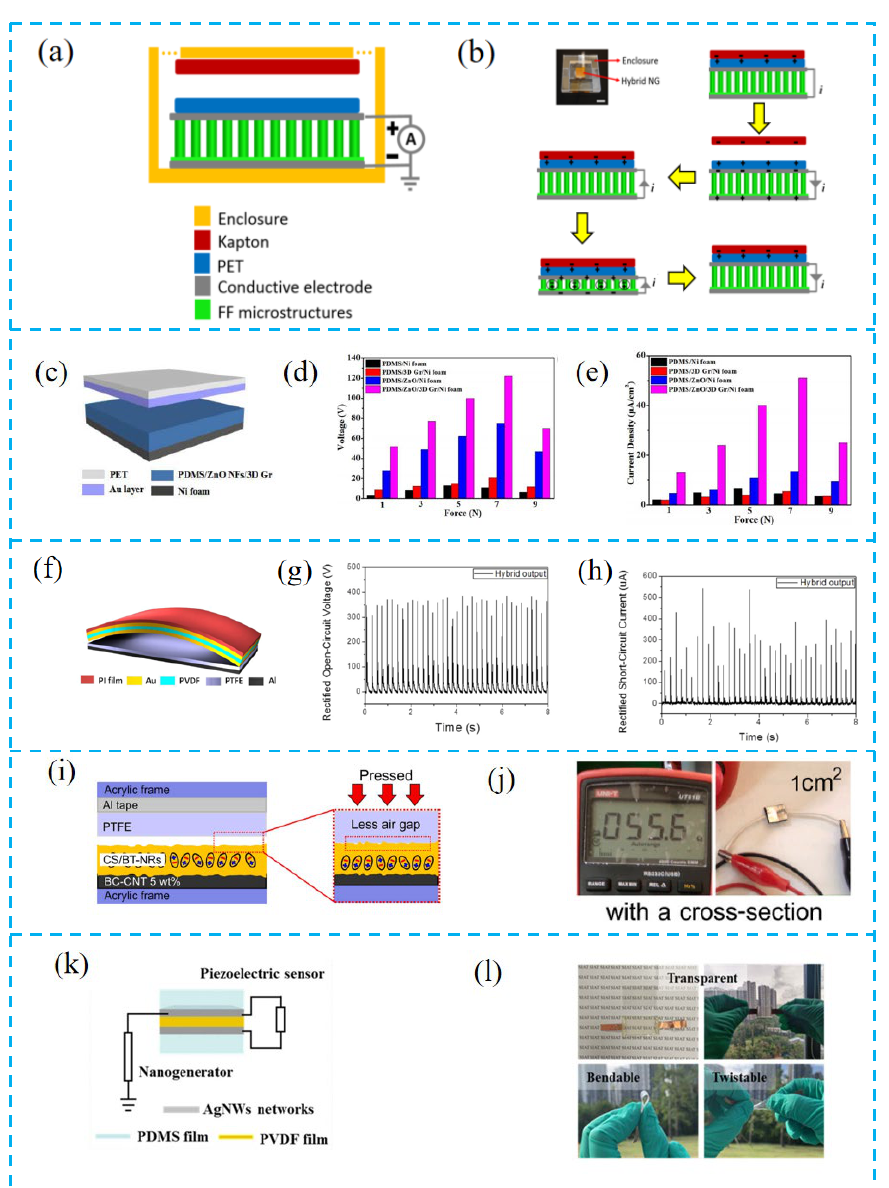
Figure 3. ( a ) Schematic of the structure of the PTCNG. ( b ) Photograph and energy conversion process of the real PTCNG. ( c ) Schematic structure diagram of a PDMS/ZnO nanoflakes/3D graphene- based PTCNG. ( d , e ) Comparison of the open-circuit voltage and short-circuit current density under different device structures. ( f ) Schematic structure diagram of an arc-shaped PVDF-PTFE-based PTCNG. ( g , h ) Open-circuit voltage and short-circuit of the arc-shaped PVDF-PTFE-based hybrid nanogenerator. ( i ) Schematic diagram of device structure based on the soft BC-CNT conformable electrode. ( j ) Conductivity of a soft BC-CNT electrode. ( k ) Schematic diagram of device structure of PTCNG. ( k ) Transparency, bending, and flexibility of constructed PTCNG. ( l ) Transparency, bending, and flexibility of constructed hybrid